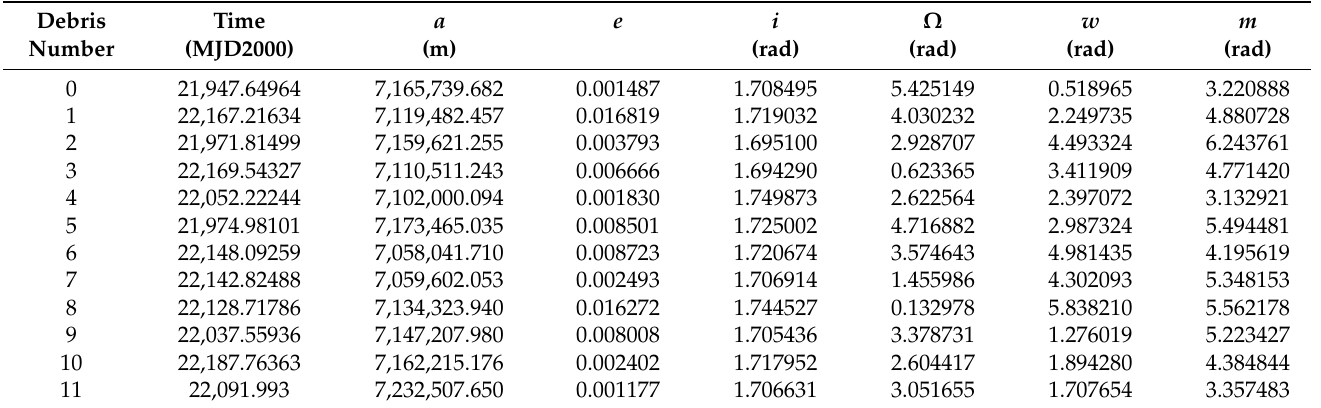
Table 9. The orbital elements of the partial space